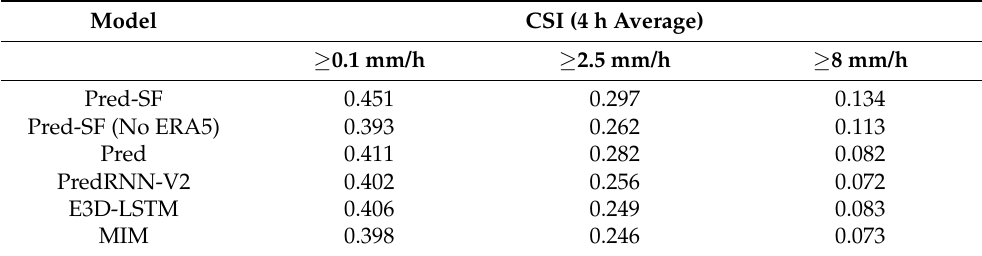
Table 2. CSI indicators of three groups of different models. We set three different levels: light rain and above ( ≥ 0.1 mm/h), moderate rain and above ( ≥ 2.5 mm/h) and heavy rain and above ( ≥ 8 mm/h). CSI and POD indexes were calculated for the three grades.